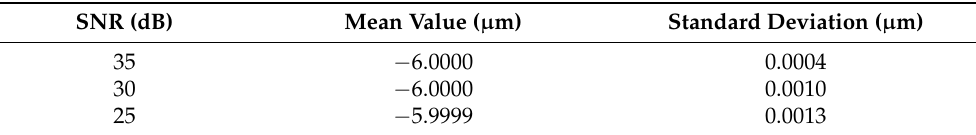
Table 2. Influences of different degrees of noise on the height of the upper surface.